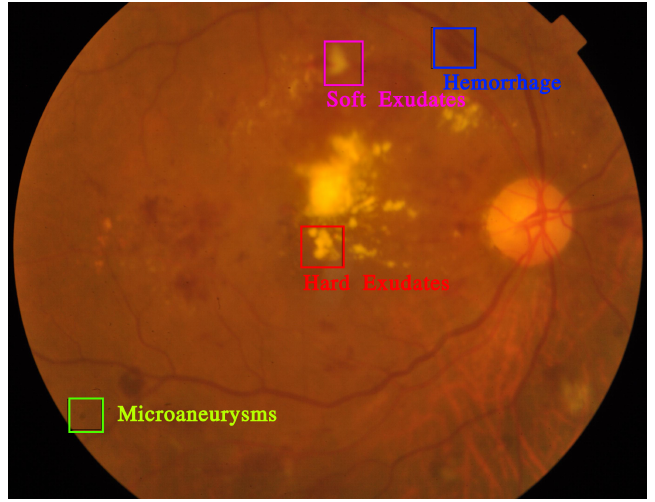
Figure 1. Illustration of DR